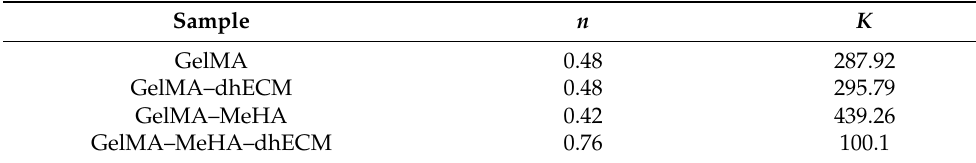
Table 1. The calculated values of n and K from the power